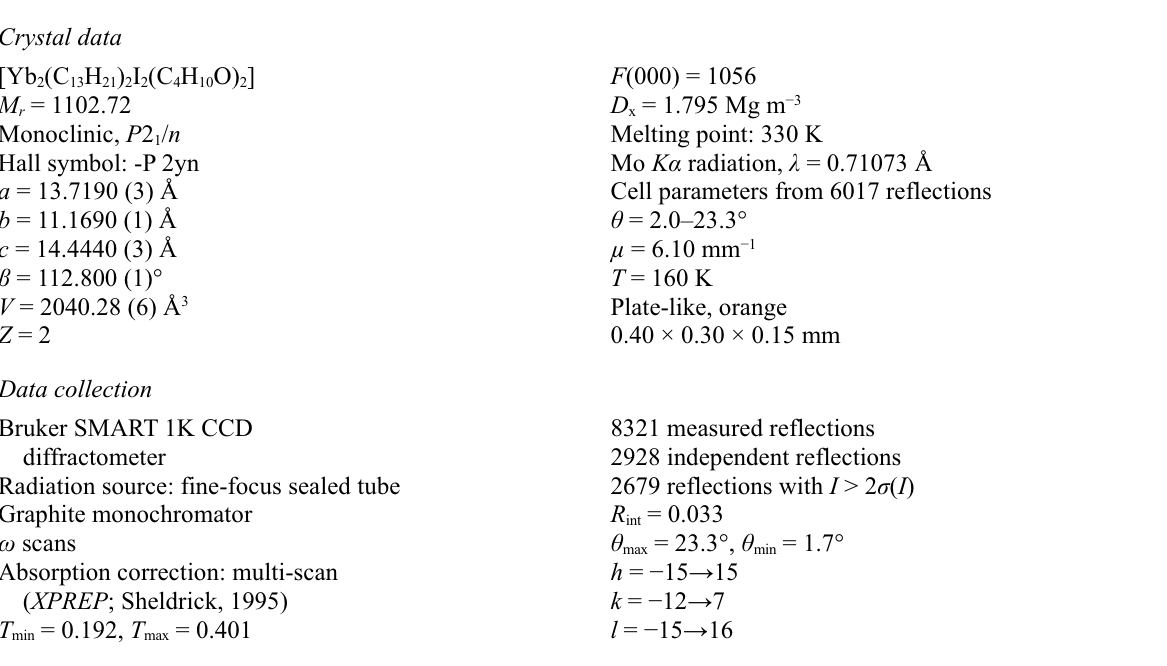
A view of the dimer (I) showing the atom labelling scheme. Hydrogen atoms have been omitted for clarity and displacement ellipsoids are drawn at the 50% probability level. Symmetry operation i: - x + 2, - y + 1, - z + 1. Di- µ -iodido-bis[(diethyl ether- κ O )( η 5 -1,3-di- tert